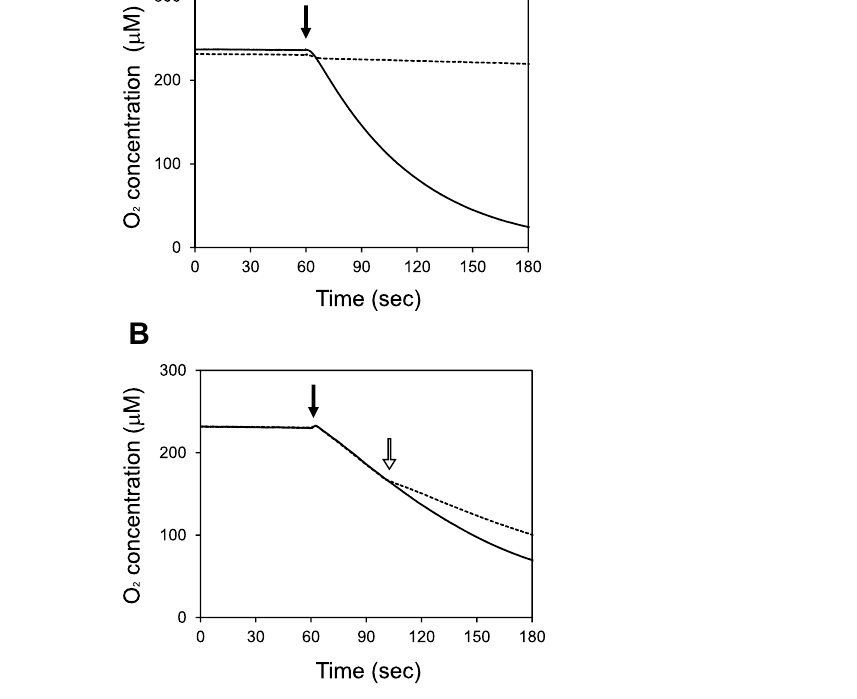
Figure 2. O 2 consumption due to catalytic activity of granaticin. The dissolved O 2 concentration in 10 mM L-ascorbic acid solution added to the culture supernatant of S. vietnamensis ( A ) and purified granaticin (0.03 mM) ( B ) was monitored using an oxygen electrode. The time points when the S. vietnamensis culture supernatant ( A ) and purified granaticin ( B ) were added are indicated by solid arrows. The open arrow in ( B ) indicates the time point for the addition of 100 units catalase. The dotted lines are the data from the measurement without the addition of culture supernatant ( A ) and with the addition of catalase ( B